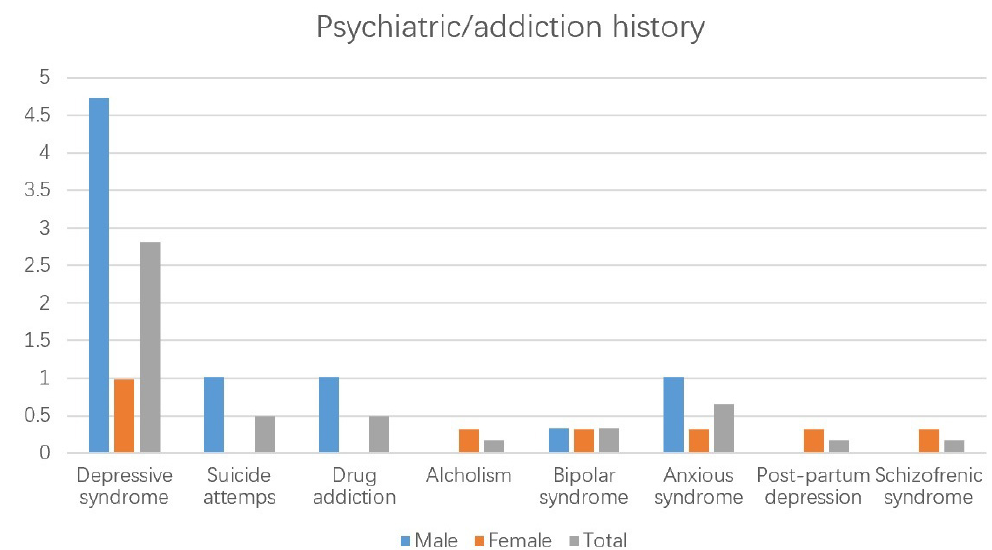
Fig. 6. Psychiatric/addiction history (cases per 100,000